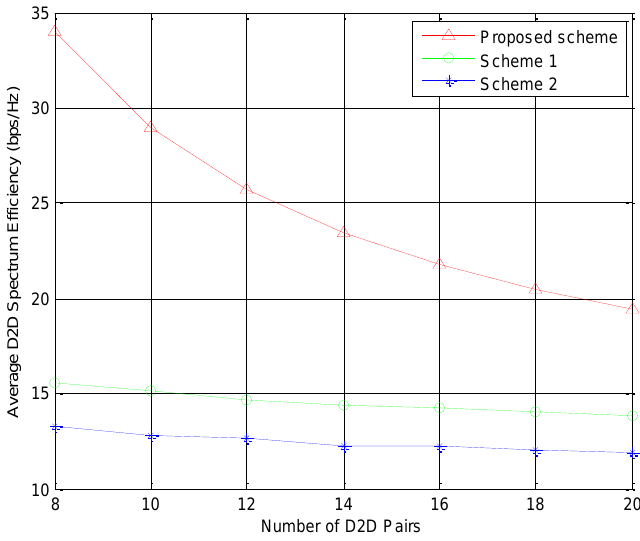
Figure 7. The average D2D spectrum efficiency versus the number of D2D pairs K .